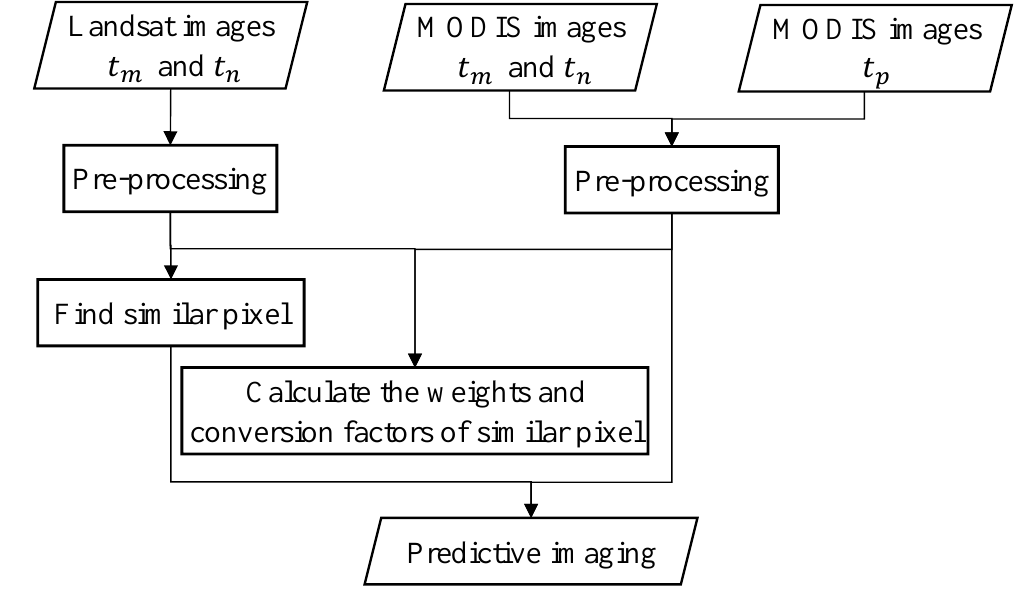
Figure 3. The calculation processes in realizing the ESTARFM model.